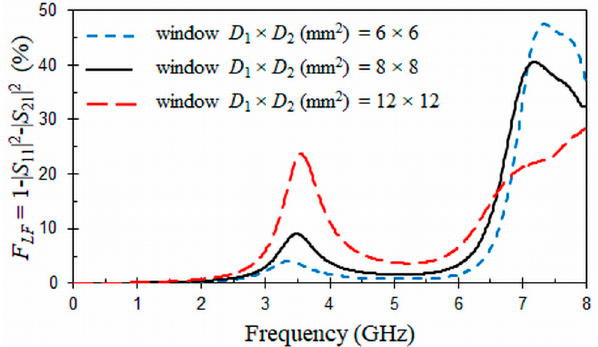
Figure 4. Forward loss factors (in %) for the proposed CPW band-stop filter as a function of frequency and different open windows D 1 × D 2 . Dimensions (mm) and permittivity: r =1.9, c = 0.3, g = 0.2, W = 0.374, S = 0.163, L 1 = 5.5, h = 0.635, and ε r = 10.2 (tg δ = 0).